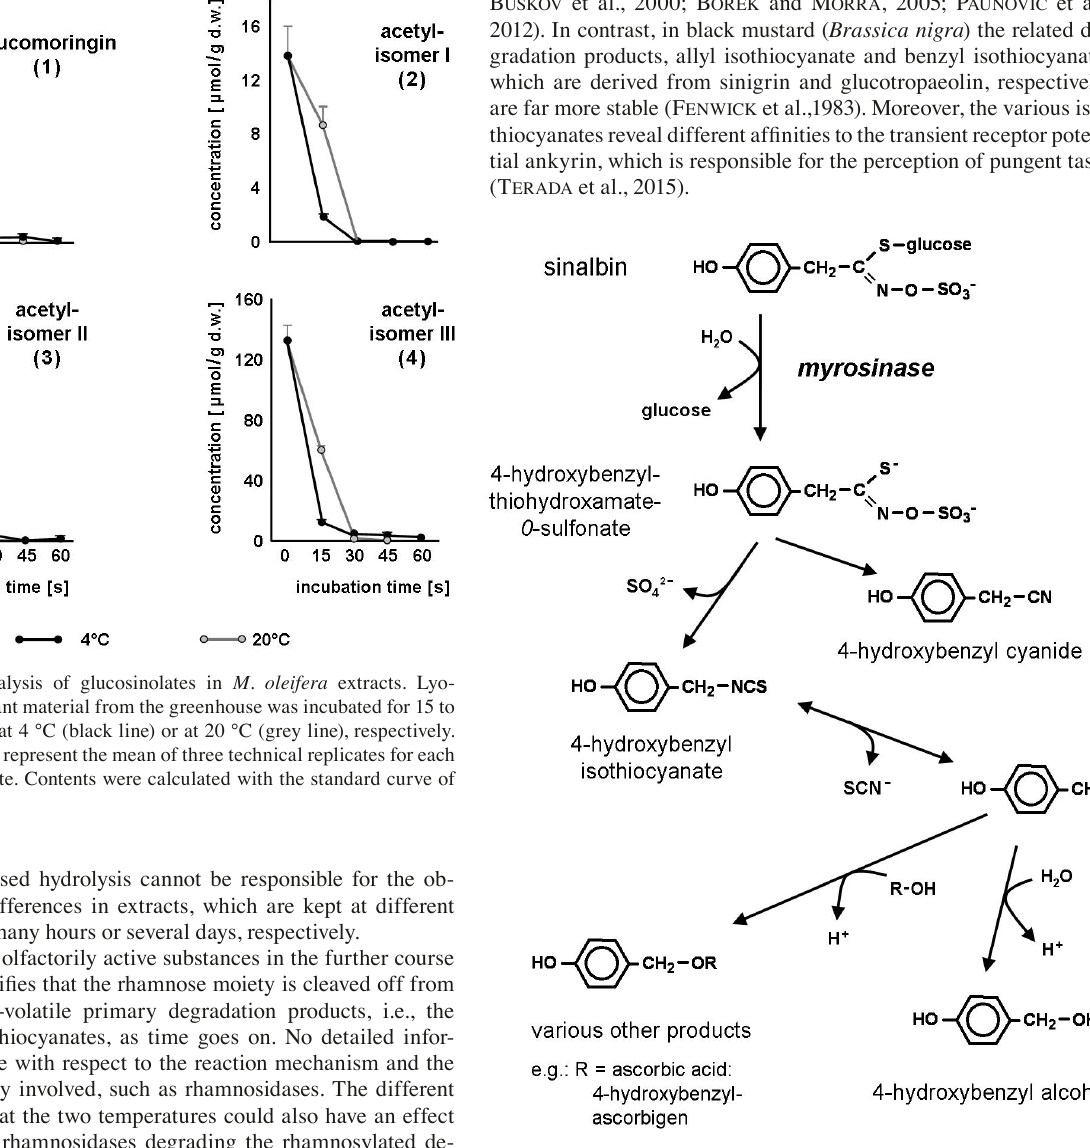
Fig. 5: Potential degradation products of 4-hydroxybenzyl isothiocyanate produced by myrosinase-catalysed hydrolysis of sinalbin according to B uskov et al.